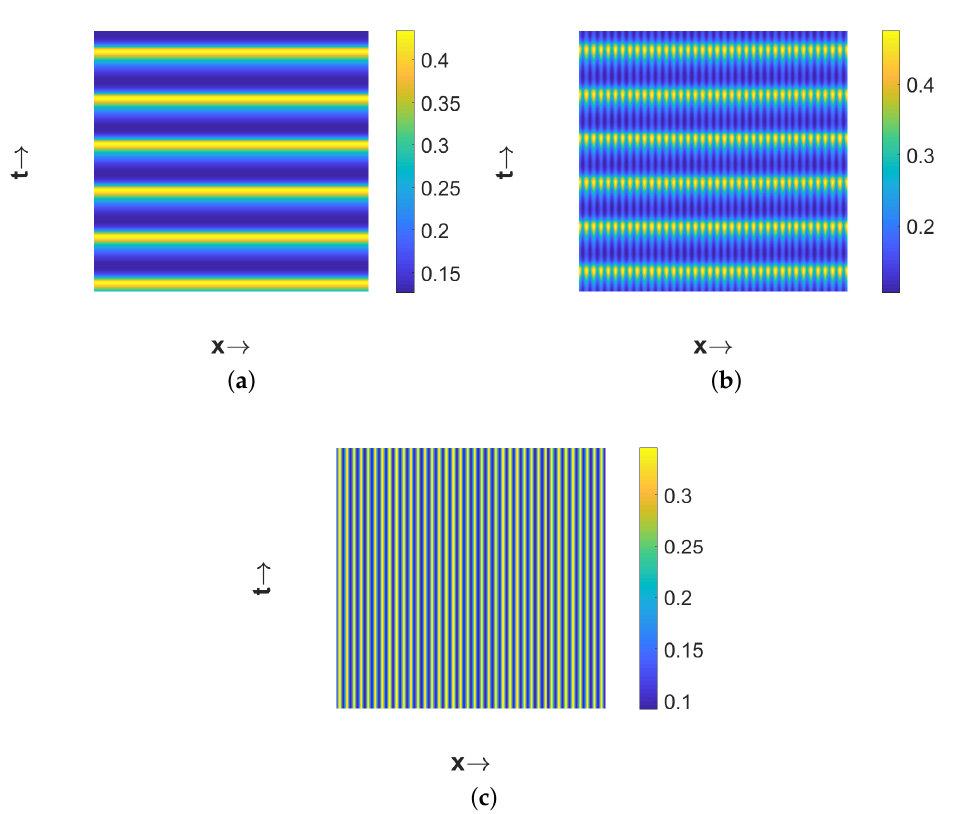
Figure 16. Plots of different types of patterns exhibited by u 1 representing the effect of the extent of nonlocality for (cid:101) = 6.0 and d 3 = 3.0. Three different patterns are obtained for ( a ) δ = 0.5; ( b ) δ = 0.7; ( c ) δ = 0.8. Other parameter values are the same as that of Figure